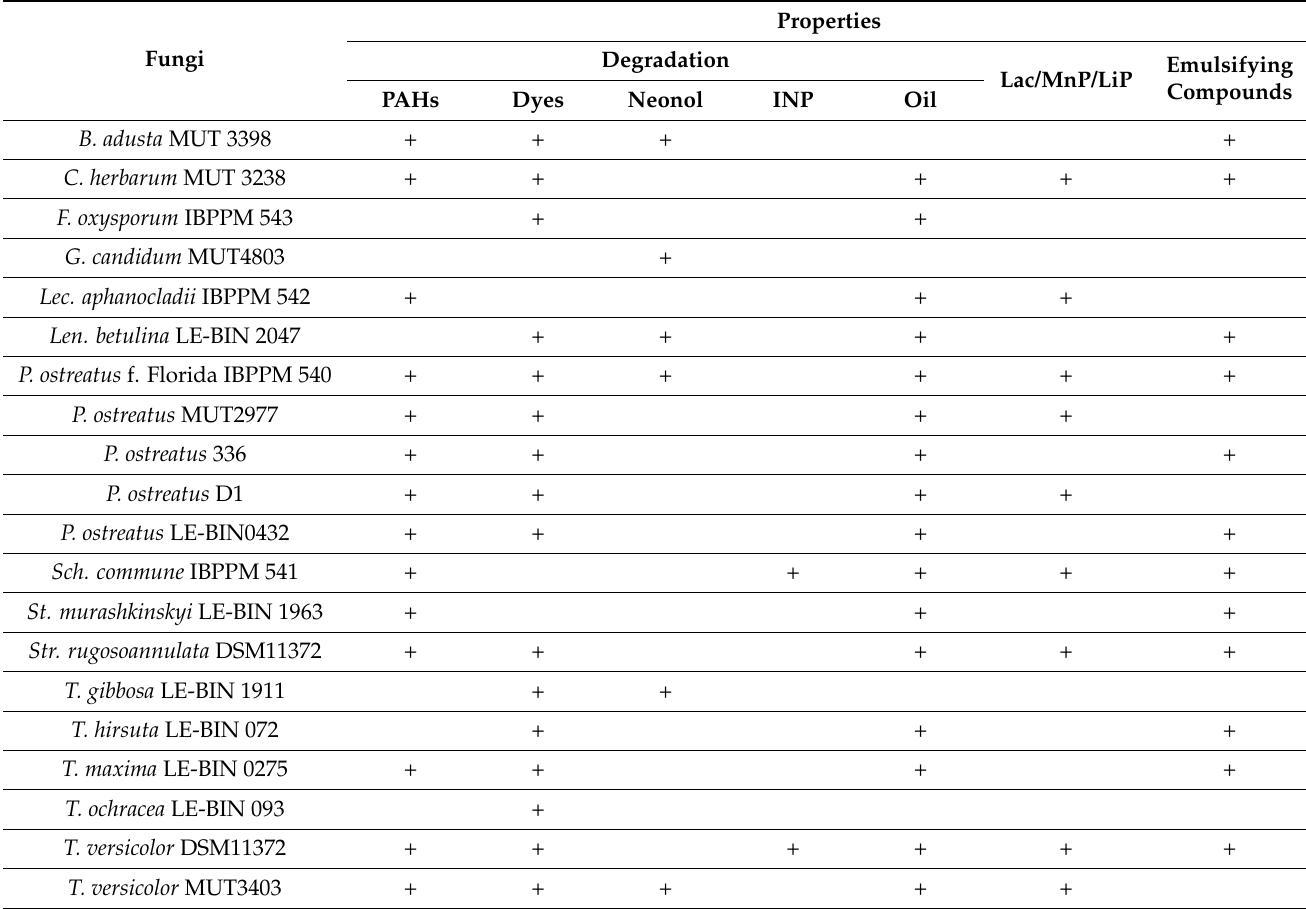
Table 4. The main properties of studied